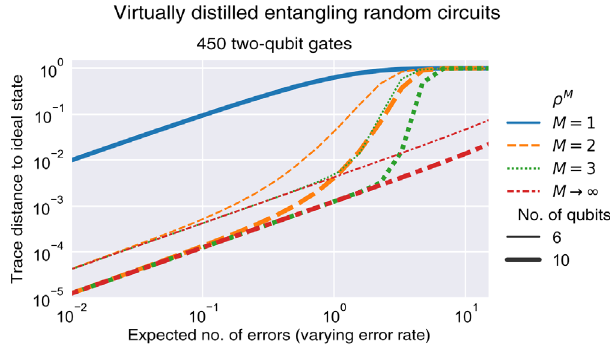
FIG. 6. The error in the unmitigated noisy states ( M ¼ 1 ), the states accessed by virtual distillation ( M ¼ 2 , 3), and the dominant eigenvector of the density matrices ( M → ∞ ) for a variety of entangling random circuits. We plot the trace distance to the state obtained from noiseless evolution, as a function of the expected number of single-qubit depolarizing errors, for six- and ten-qubit systems (demarcated by the thickness of the symbols). We vary the expected number of errors by varying the error rate per gate, fixing the number of two-qubit gates to be 450. It is clear that there is a maximum number of expected errors for which the technique is effective, and below a certain error rate, the achievable improvement is fixed by the drift in the dominant eigenvector ( M → ∞